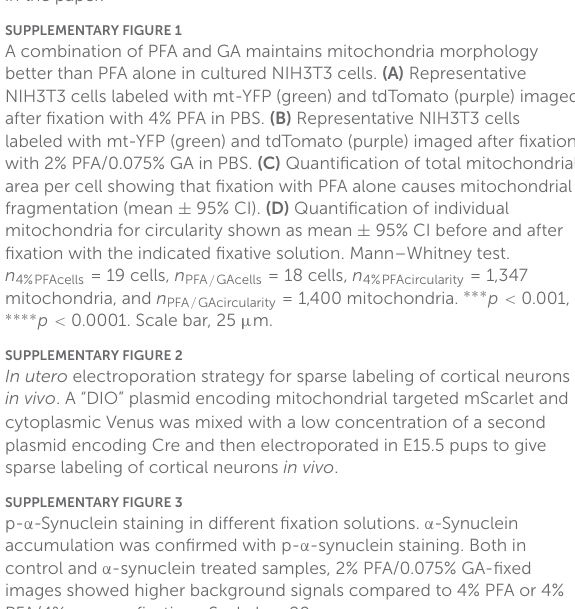
SUPPLEMENTARYTABLE1 Fixation methods and outcomes. A table listing the fixation conditions and their outcomes for both in vitro and in vivo conditions in the paper.